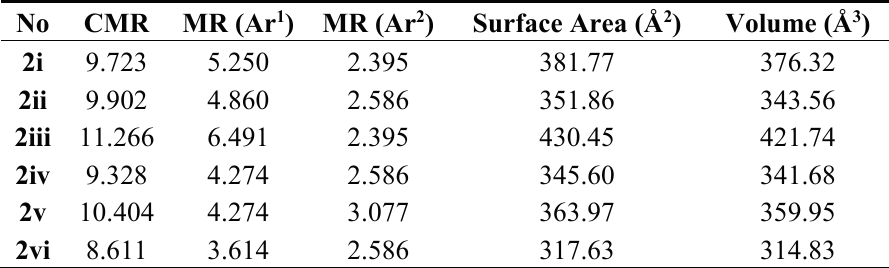
Table 4. Theoretical calculation of molar refractivity, surface area and volume for pyrrole derivatives 2i – 2vi